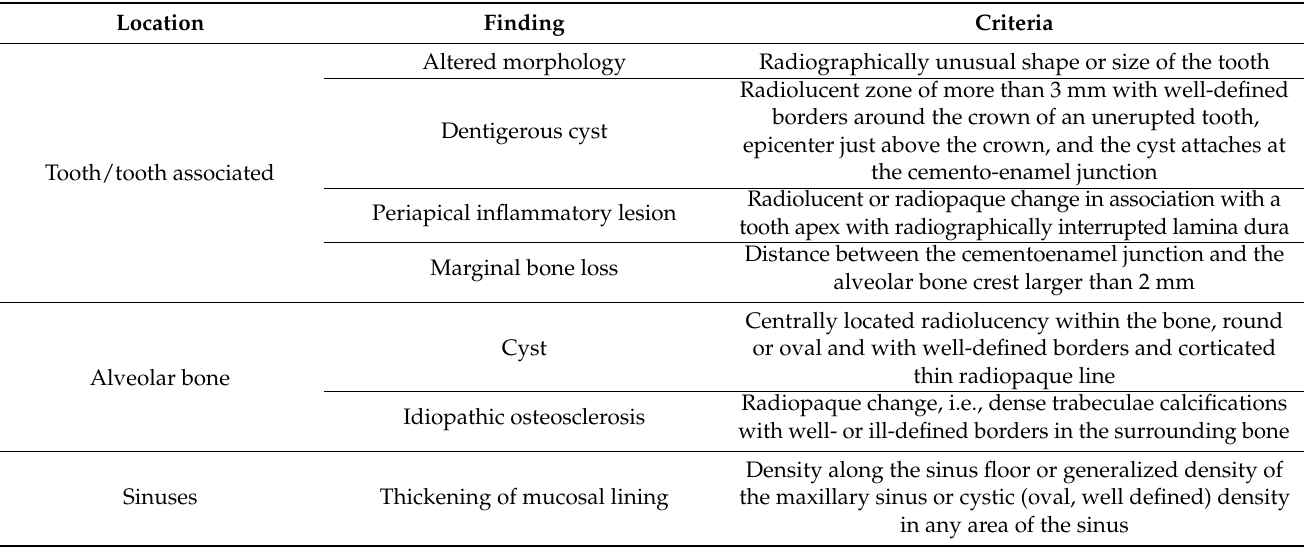
Table 1. Radiographic Criteria used for Recording of